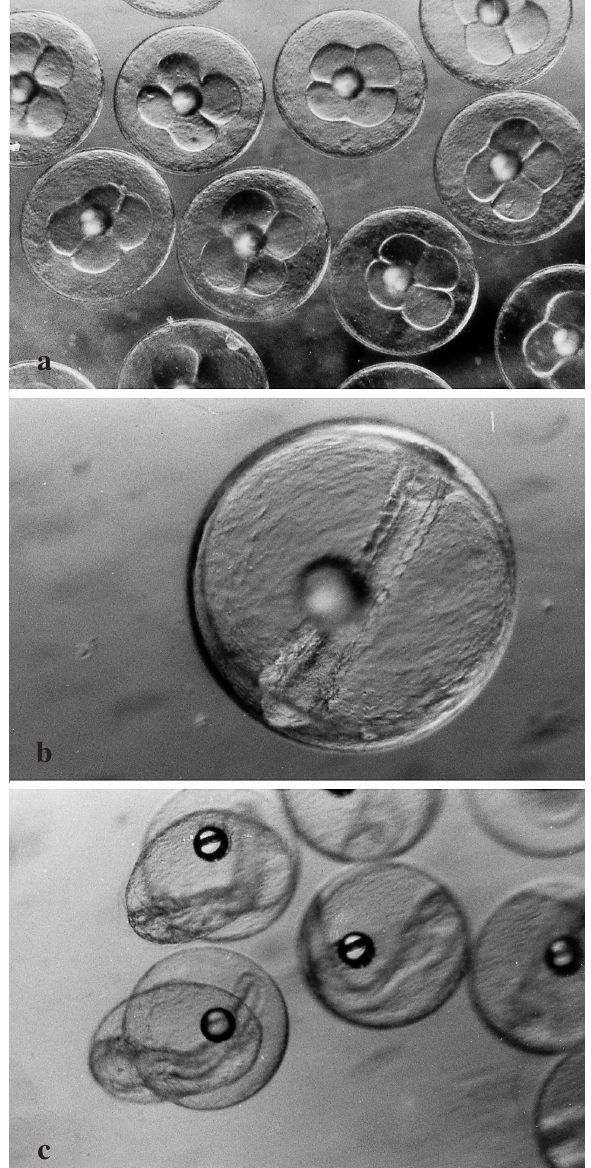
F IG . 1. – Goldblotch grouper eggs at different stages of embryoge- nesis: a) four-cell stage, b) early embryo, c)